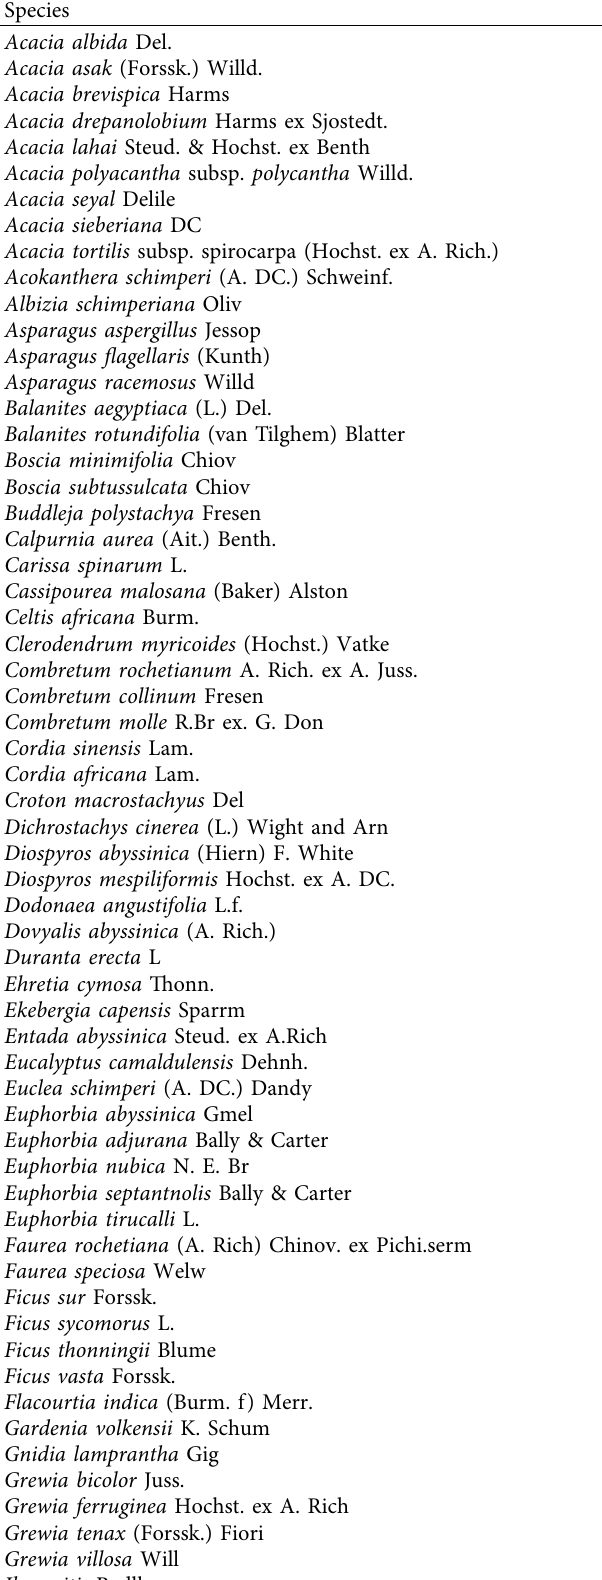
Table 1: List of woody species in the Loka Abaya National